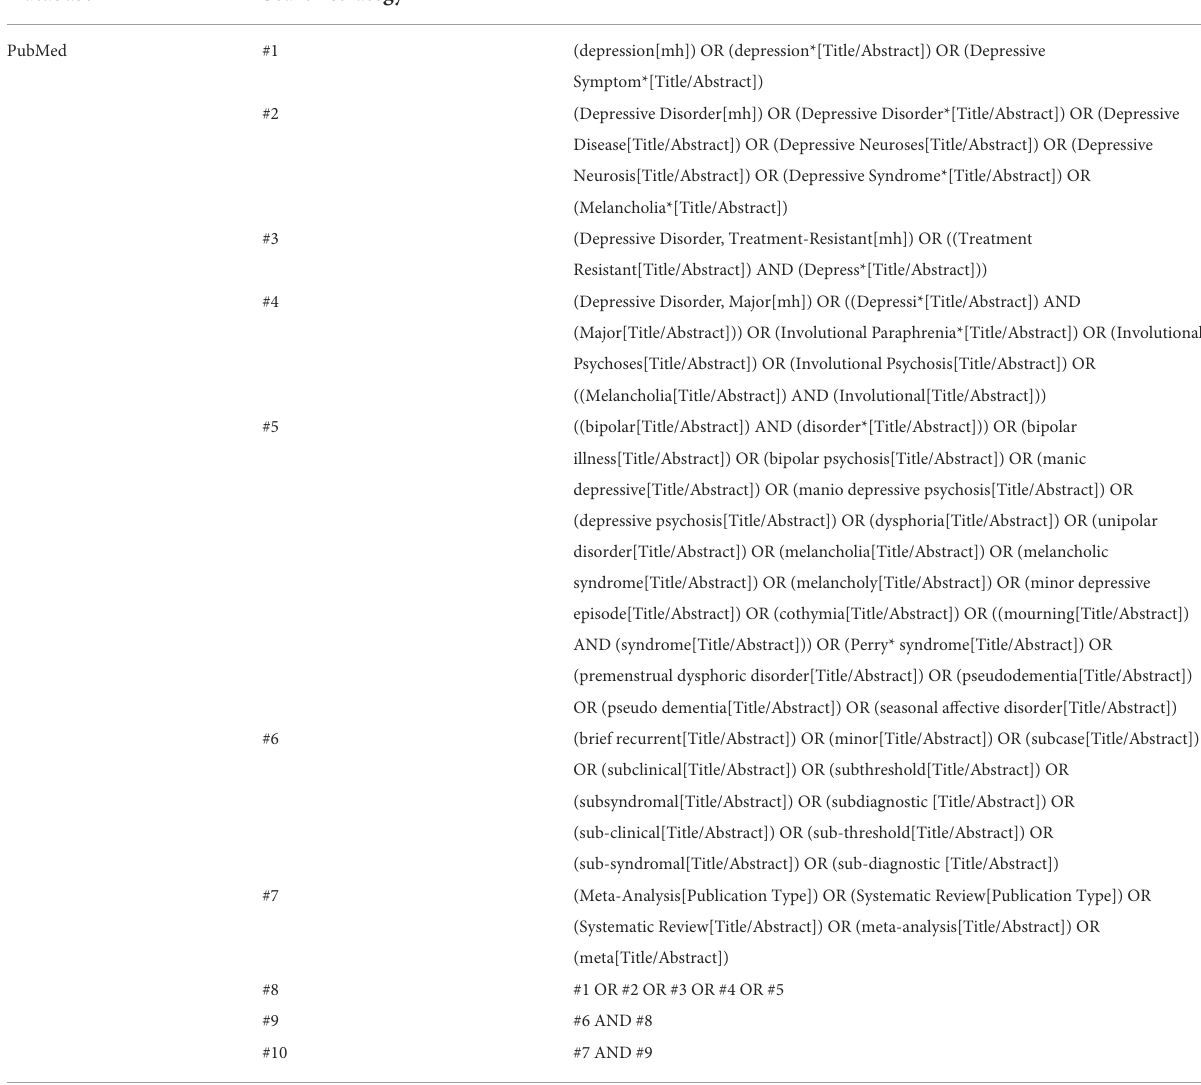
TABLE 1 The search strategy of